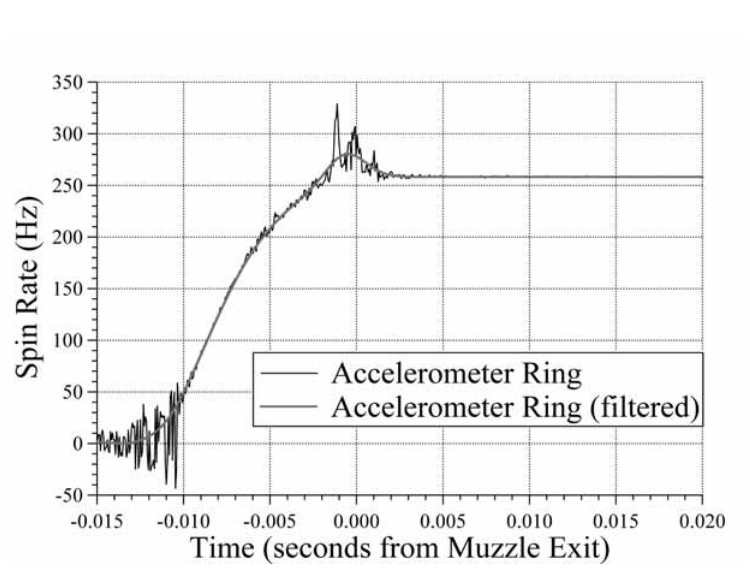
Fig. 9. Projectile balloting vs. time.